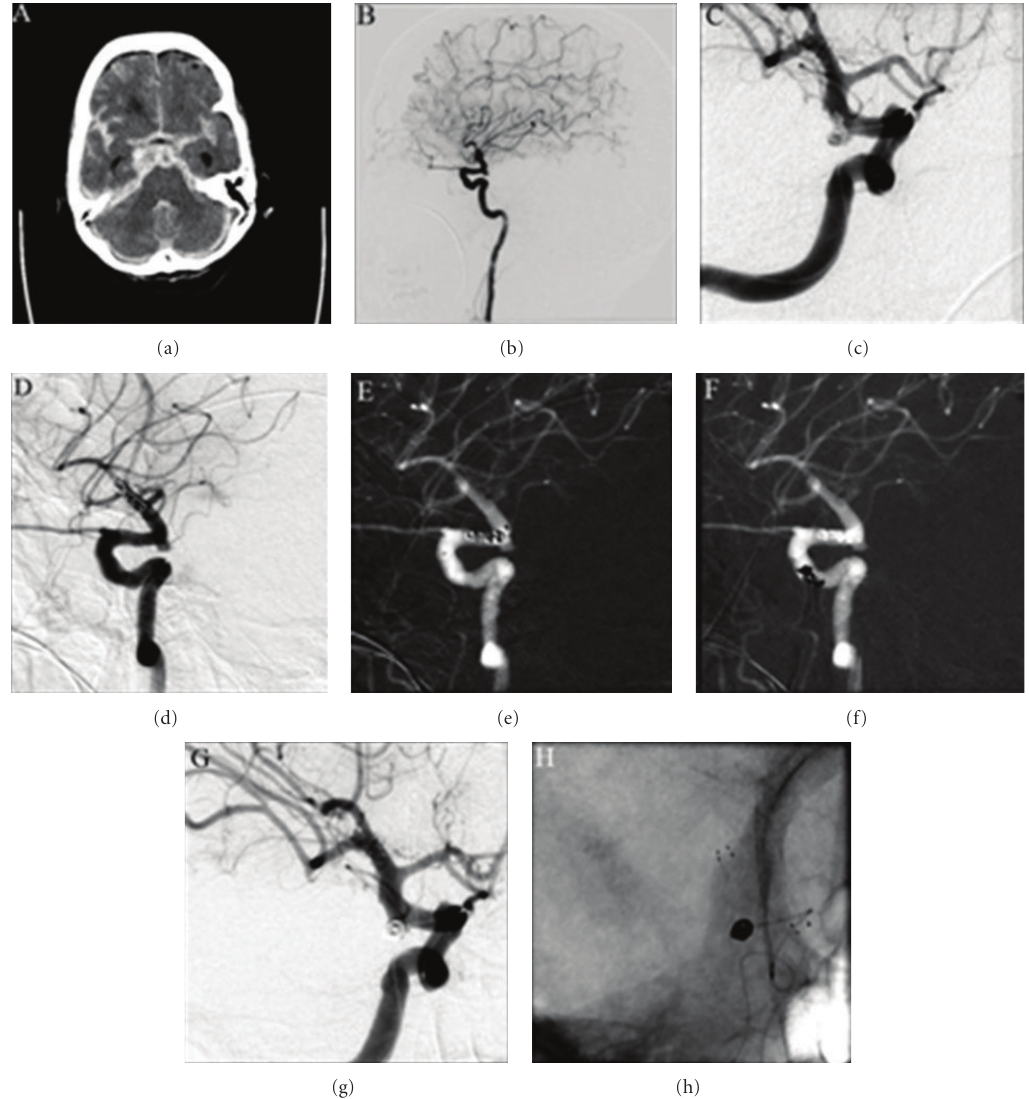
Figure 2: (a) Noncontrast head CT demonstrates di ff use SAH. (b) A lateral view of the right ICA arteriogram reveals a wide-necked PCOM aneurysm. (c) Right ICA injection angiogram at the working angle demonstrates partial coil prolapse following initial stent-assisted coiling. (d) Attempts to place an overlapping stent to hold the prolapsed coil in place resulted in anterior migration of the stent and complete coil herniation. (e) and (f) Lateral roadmap angiograms demonstrate sequential retrieval of the stent and coil mass. (g) and (h) After complete removal of the migrated stent and coils, a repeated attempt at stent-assisted coiling of the ruptured aneurysm is successful. A working view of left ICA angiogram and plain X-ray demonstrate final placement of the stent and